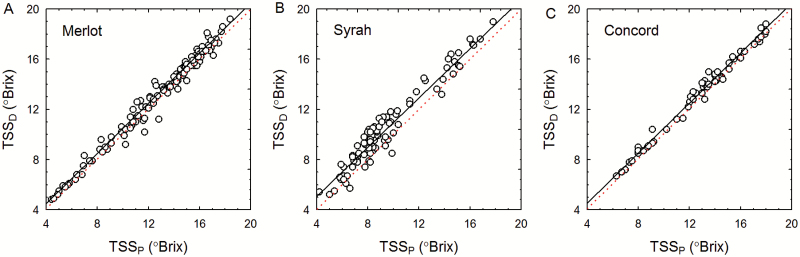
Association between total soluble solids (TSS) in the proximal (TSSP) and distal (TSSD) end sections of (A) Merlot, (B) Syrah, and (C) Concord grape berries. Regression analysis gave the following results for (A) r=0.99, P<0.001, y=0.40 + 0.99x, n=104; (B) r=0.98, P<0.001, y=1.07 + 0.99x, n=95; (C) r=0.98, P<0.001, y=0.50 + 0.99x, n=55. The dotted line in each panel is the 1:1 line with intercept=0. (This figure is available in colour at JXB online.)